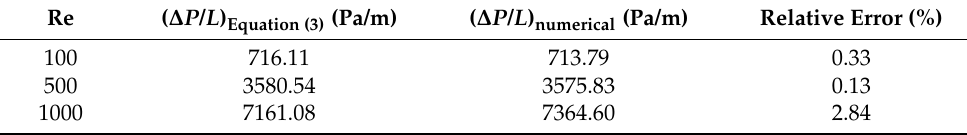
Table 1. Pressure drop for fully developed Newtonian flows in the region before the